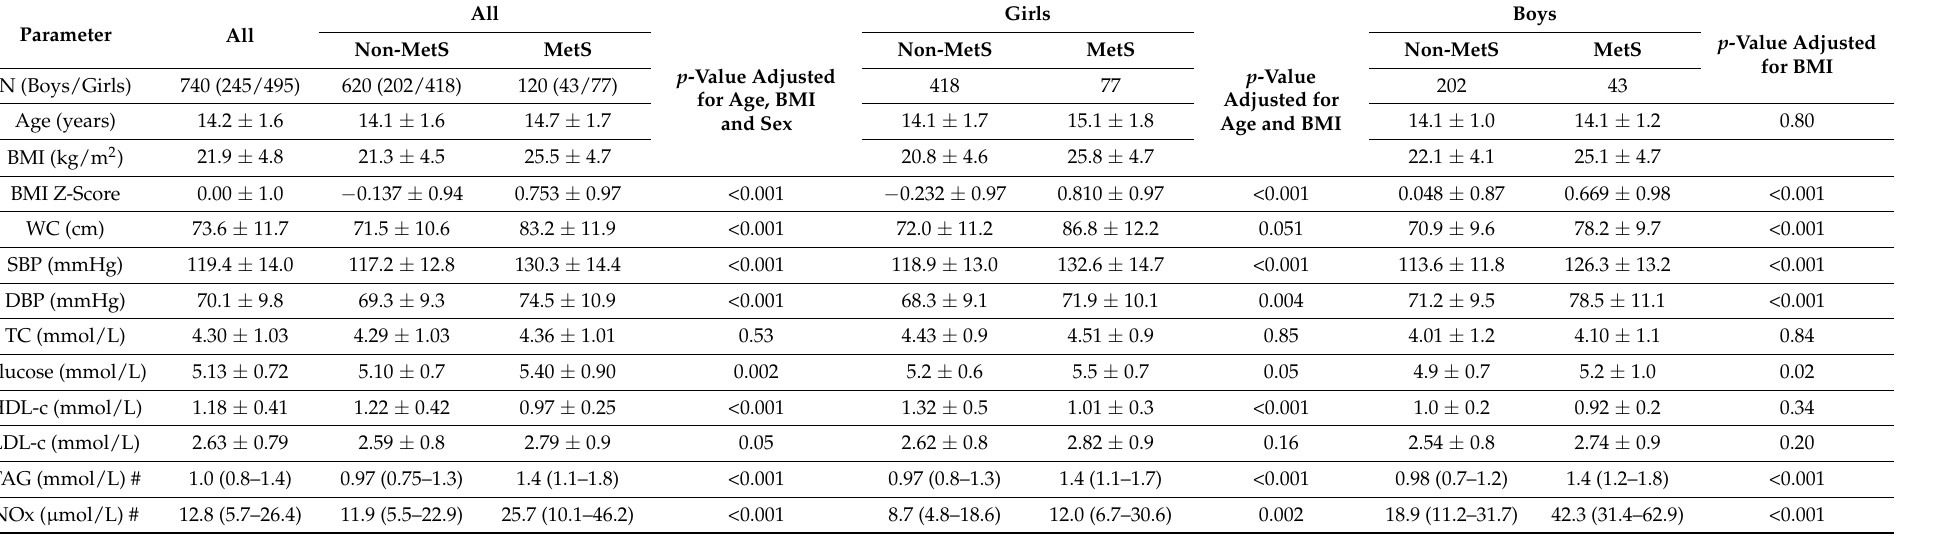
Table 1. Clinical characteristics of